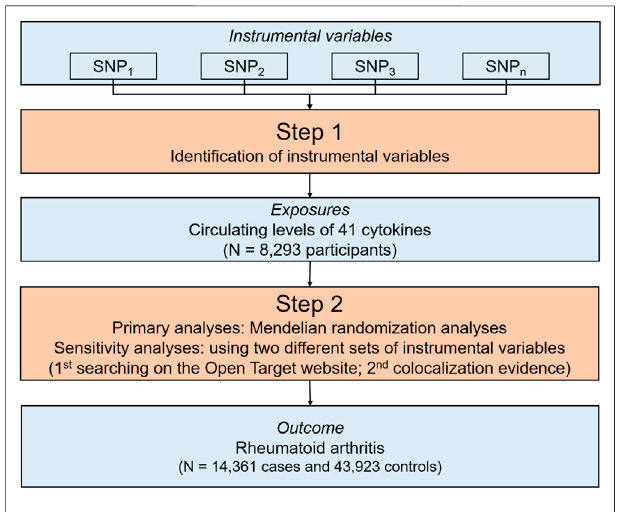
FIGURE 1 | An overall design of the present study. Abbreviations: MR, Mendelian randomization; N, number; SNP, single nucleotide